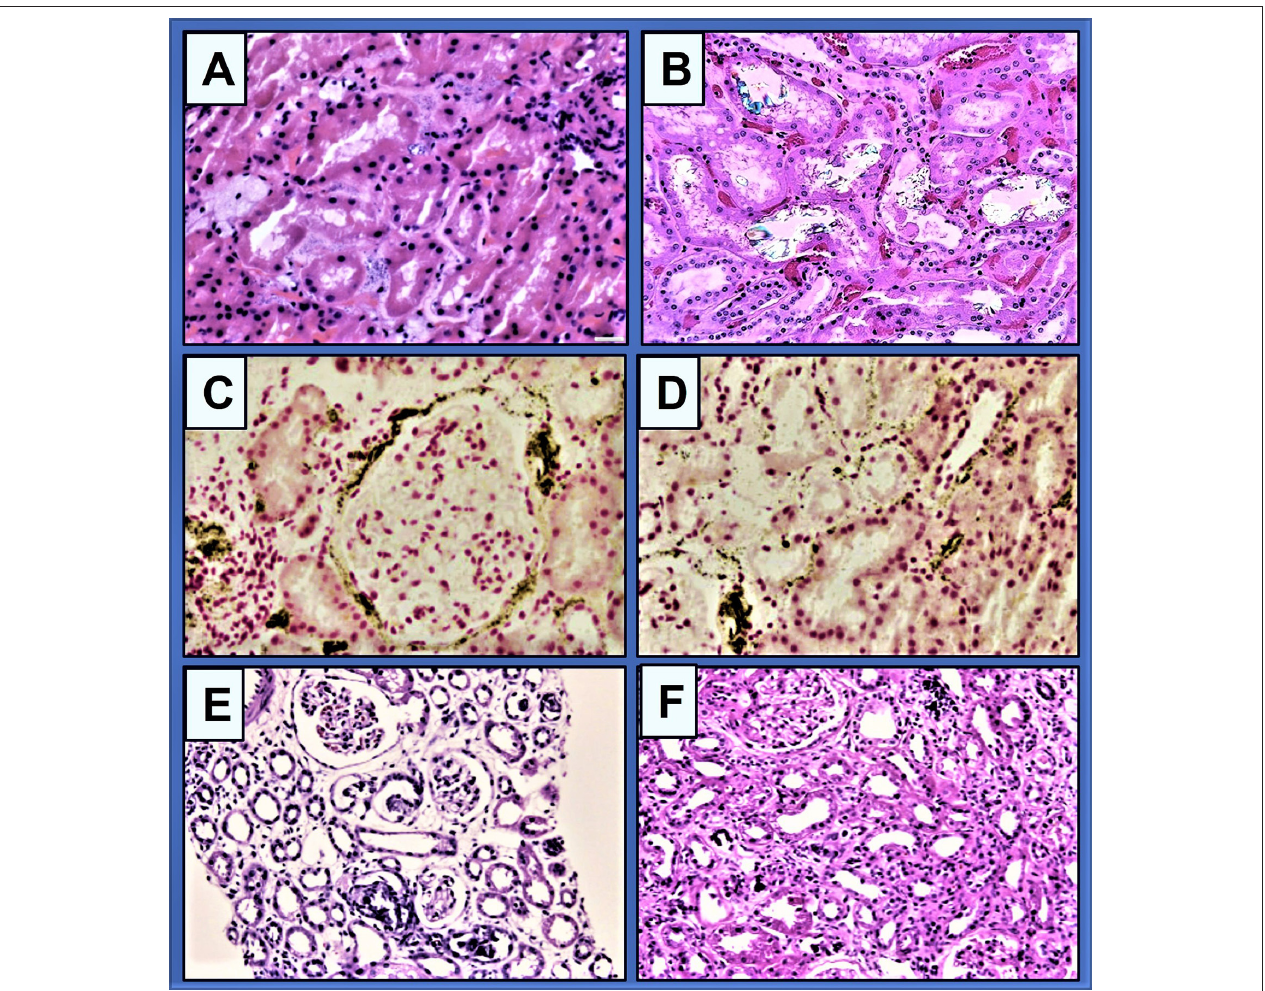
FIGURE 3 | (A) Granular and globular morphologic characteristics of CaPO 4 crystal deposition in renal biopsies. Crystals are mildly basophilic on haematoxylin-eosin stained and non-birefringent under polarised light (original magnification, × 400; bar, 20 µ m) (after Zhang et al., 2021); (B) Granular crystals in a renal biopsy, in inherited crystalline nephropathy (after Perazella and Herlitz, 2021); (C,D) There are granular CaPO 4 crystals in the interstitium and along the tubular basement membranes, peritubular capillaries, and Bowman capsules. Confirmation of CaPO 4 using von Kossa staining (magnification, × 400; bar, 20 µ m) (after Zhang et al., 2021); (E,F) An example of phosphate nephropathy illustrating intratubular CaPO 4 crystals, tubular atrophy, and interstitial fibrosis (haematoxylin and eosin stain: after Fogo, AB. AJKD) ( Fogo et al.,